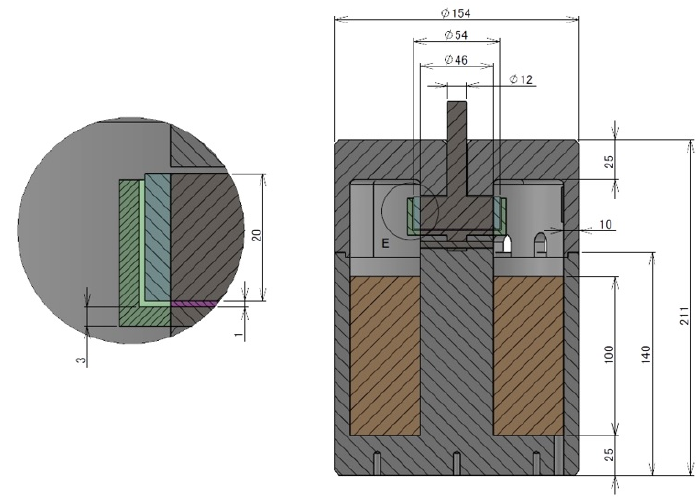
Figure 4. Test cell for parallel plate setting. Circle E is the closeup part.